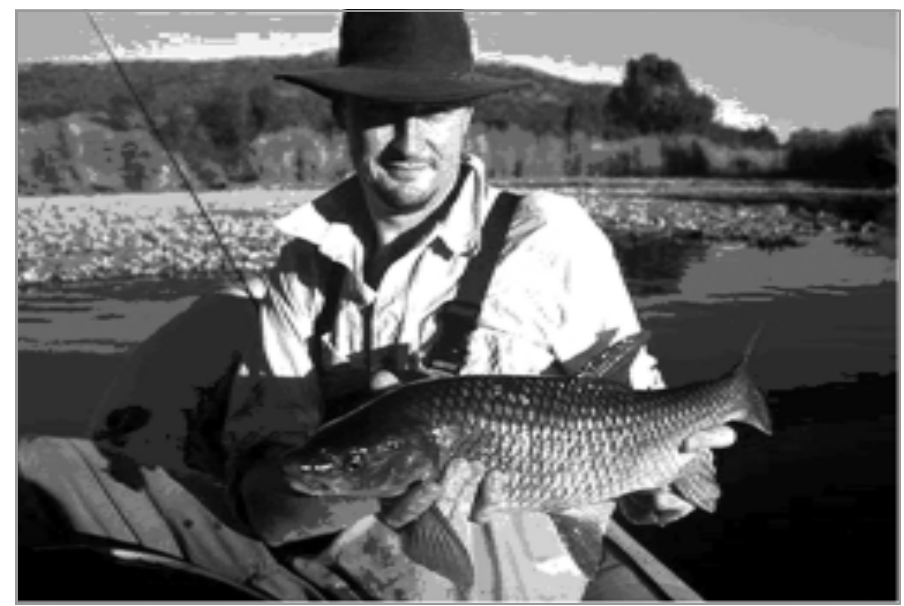
Illustration 8: Fly fisherman, Keith Wallington, with a yellow fish he caught in the Middle Vaal (below the Vaal River Barrage) in the winter season. Once these fish are caught, they are released in the water.